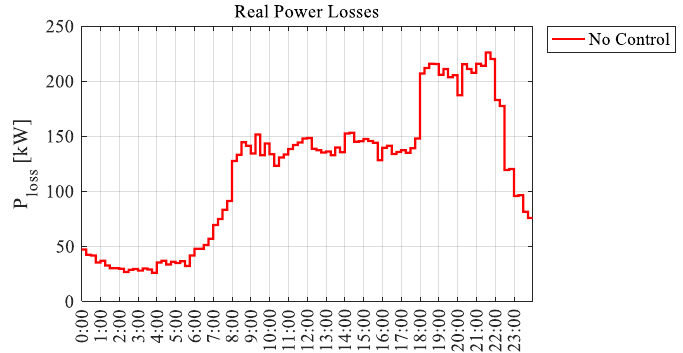
Figure 12. Initial results: real power losses profile.